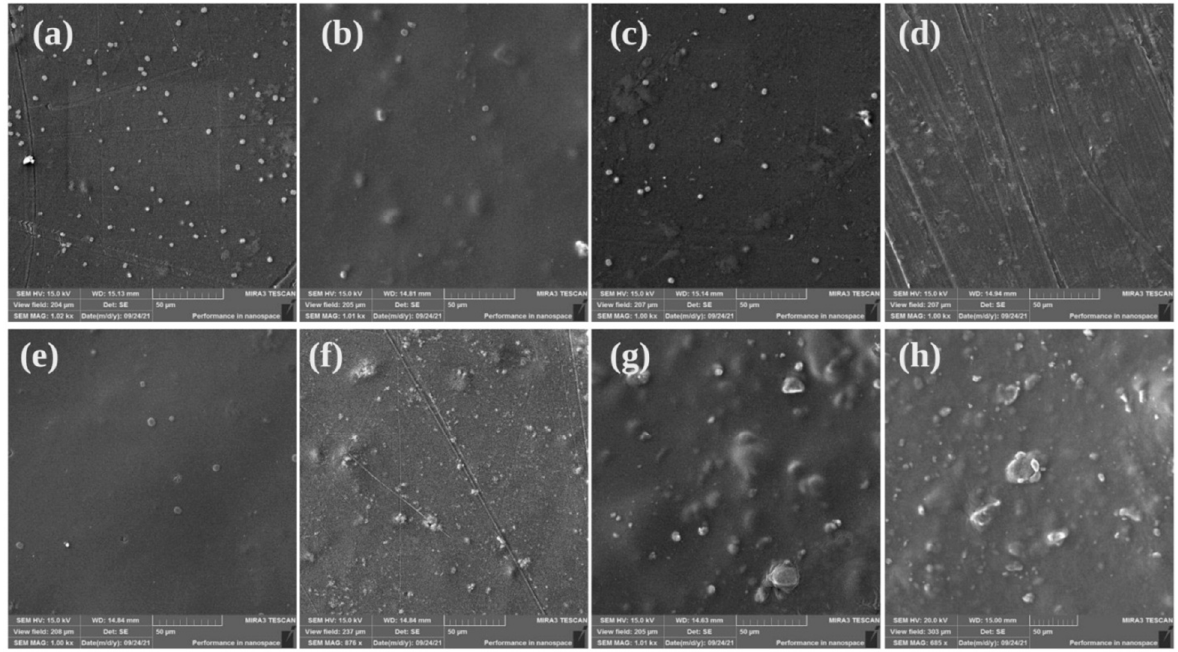
Figure 6. Scanning Electron Microscopy (SEM) images of the films. ( a ) Ch film; ( b ) Ch/HNTs—5%; ( c ) Ch/HNTs—15%; ( d ) Ch/HNTs—30%; ( e ) Ch/BEO; ( f ) Ch/BEO/HNTs—5%; ( g ) Ch/BEO/HNTs— 15%; ( h )